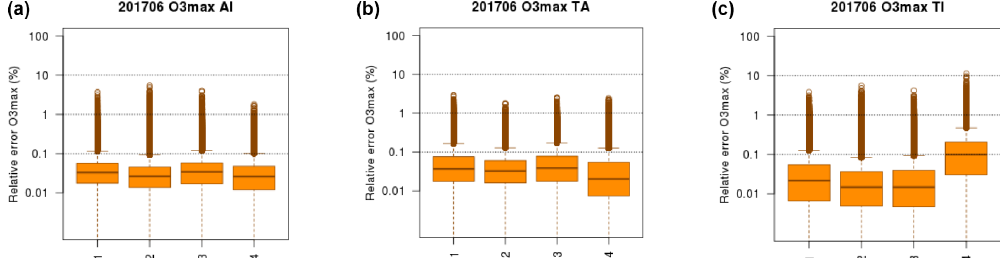
Figure 10. Same as Fig. 9 for O 3